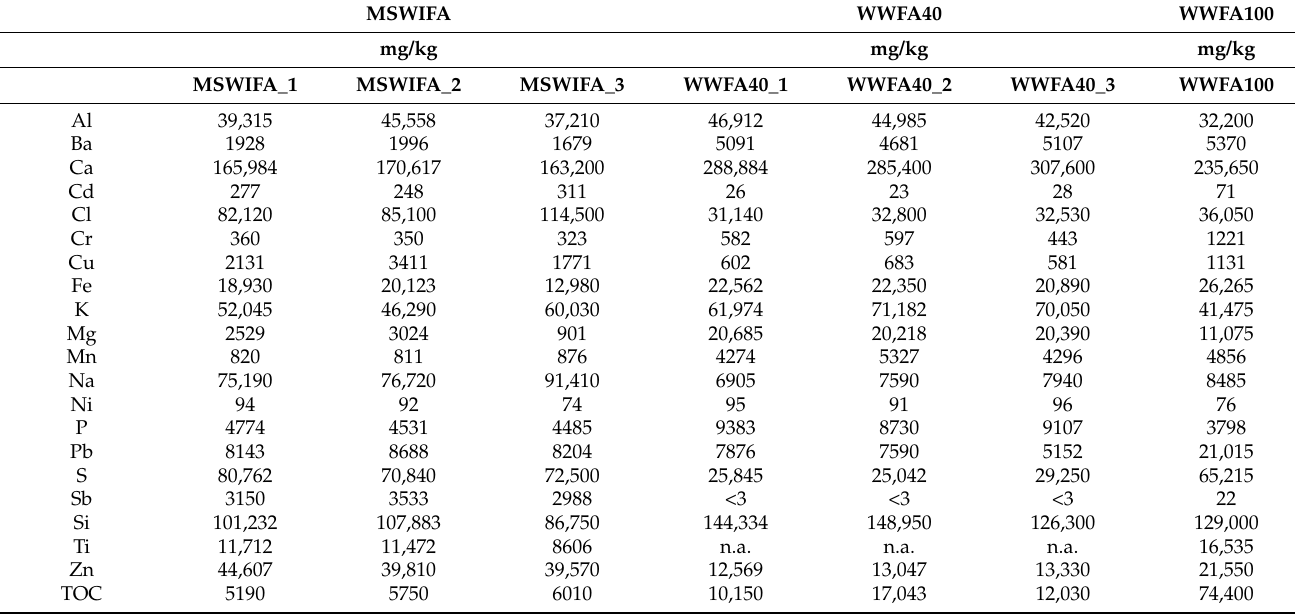
Table 2. Elemental composition of the analyzed municipal solid waste fly ash (MSWIFA) and waste wood fly ash types